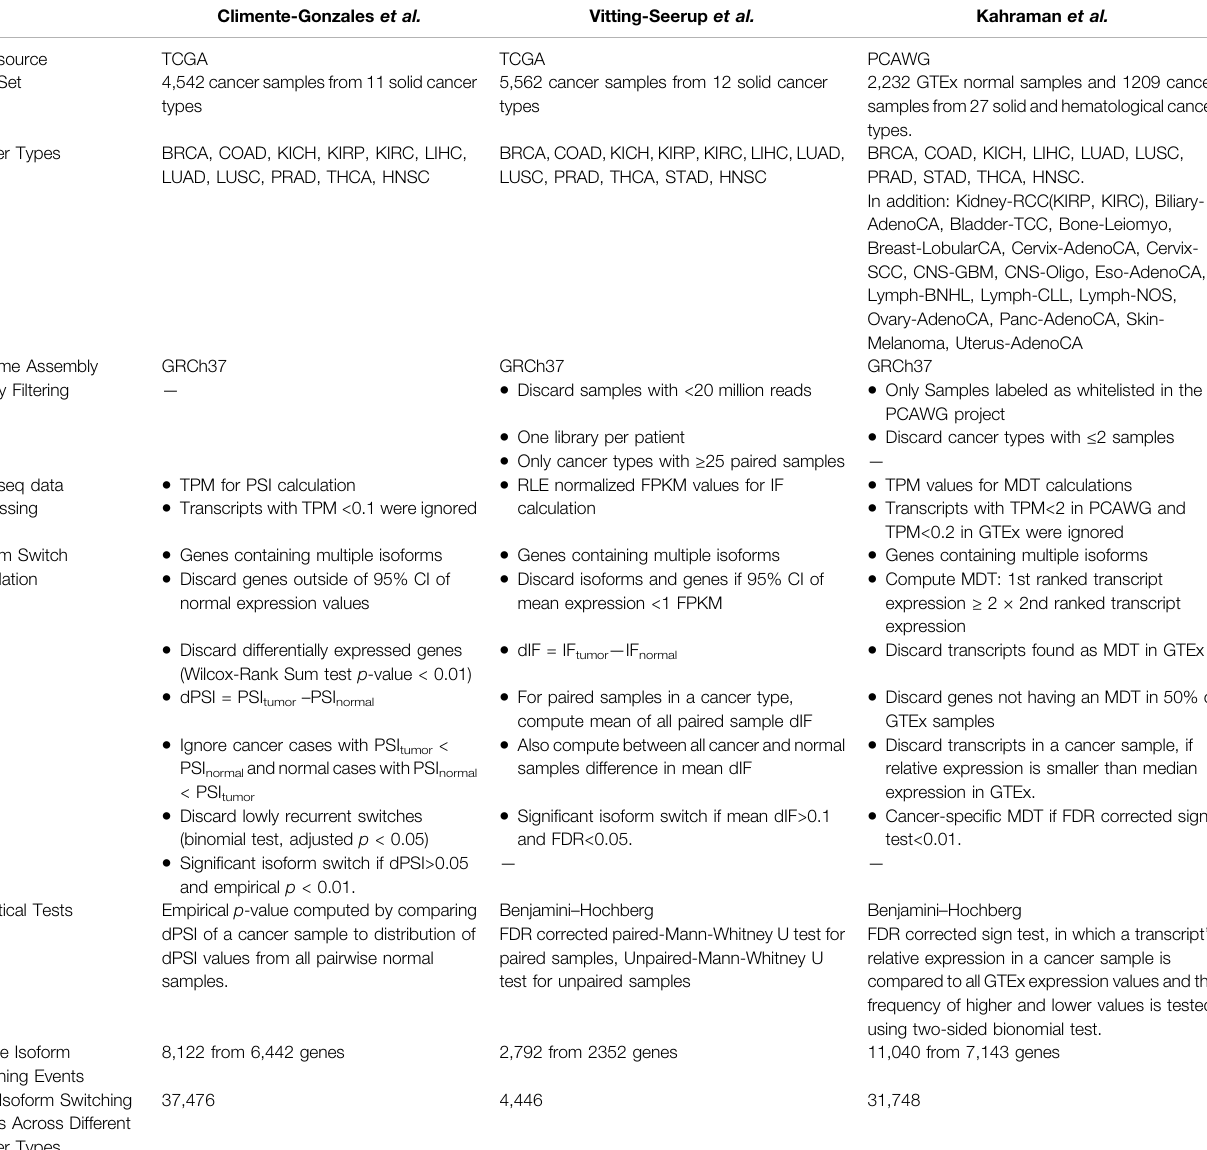
TABLE 1 | Technical details of recent pan-cancer studies on isoform switching events. Abbreviations: CI (cid:1) Con fi dence Interval, FDR (cid:1) False Discovery Rate, FPKM (cid:1) Fragments Per Kilobase of transcript per Million mapped fragments, GRCh37 (cid:1) Genome Reference Consortium human build version 37, IF (cid:1) Isoform Fraction, MDT (cid:1) Most Dominant Transcript, PCAWG (cid:1) Pan-Cancer Analysis of Whole Genomes, PSI (cid:1) Percent-Spliced-In, RLE (cid:1) Relative Log Expression, TCGA (cid:1) The Cancer Genome Atlas, TPM (cid:1) Transcripts Per Million. De fi nitions of cancer types ’ abbreviations can be found in the abbreviation list at the end of the manuscript. Climente-Gonzales et